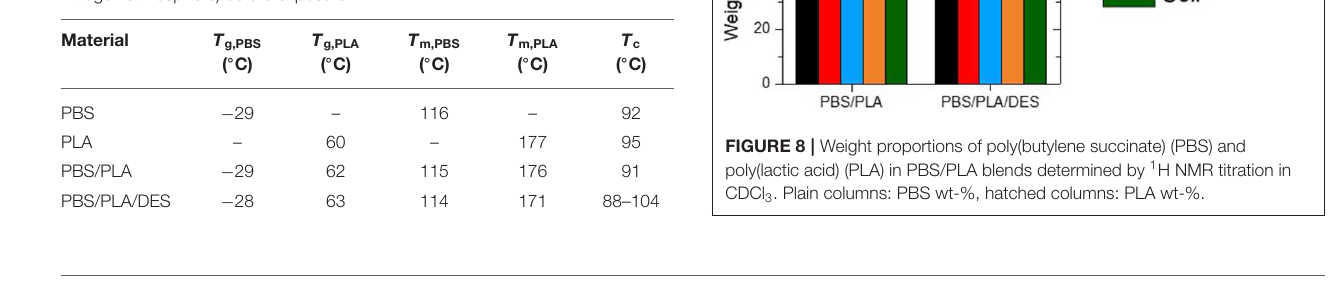
TABLE 5 | M n of poly(butylene succinate) (PBS)/poly(lactic acid) (PLA) and PBS/PLA/deep eutectic solvents (DES) blends determined using size exclusion chromatography (SEC) and 1 H NMR (PBS end group titration) after 3 months degradation. M n · ( kgmol − 1